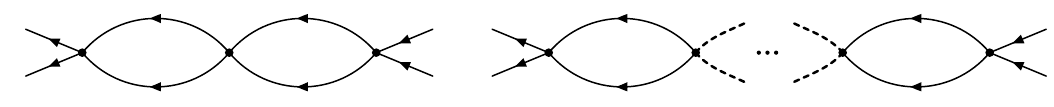
Figure 1 . One-loop bubble diagram contribution to two-body S-matrix.